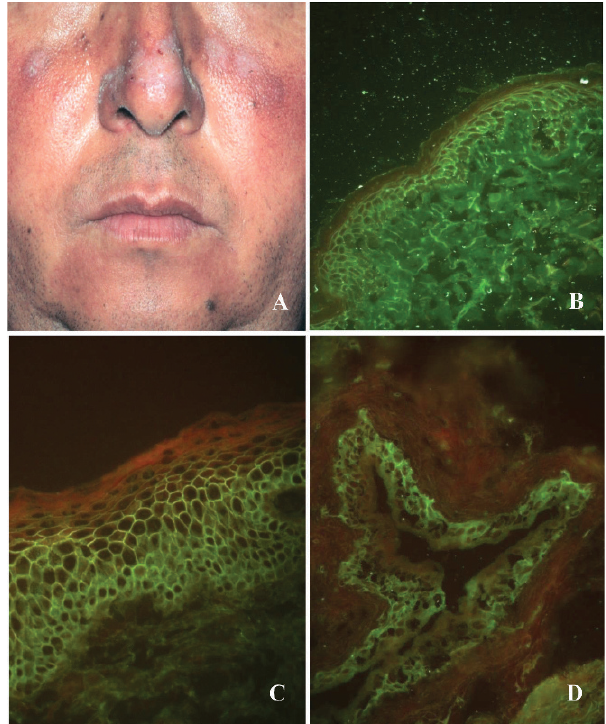
Figure 2 - (A) Clinical aspects of the lesions of a PV patient and (B) the results of direct immunofluorescence demonstrating inter- cellular intraepidermal IgG deposits ( 6 400); (C) indirect immuno- fluorescence using human foreskin as a substrate showing intercellular intraepidermal IgG deposits ( 6 400); and (D) indirect immunofluorescence using rat bladder epithelium as a substrate demonstrating intercellular intraepithelial IgG deposits (